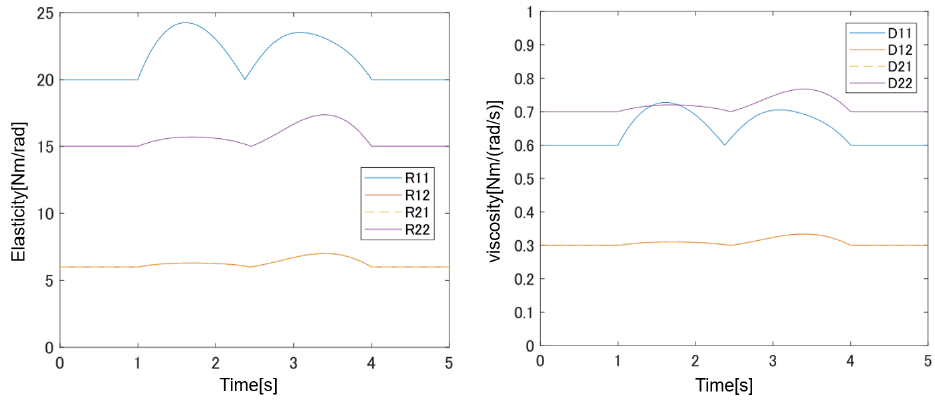
Figure 6. Multi-joint human arm elasticity and